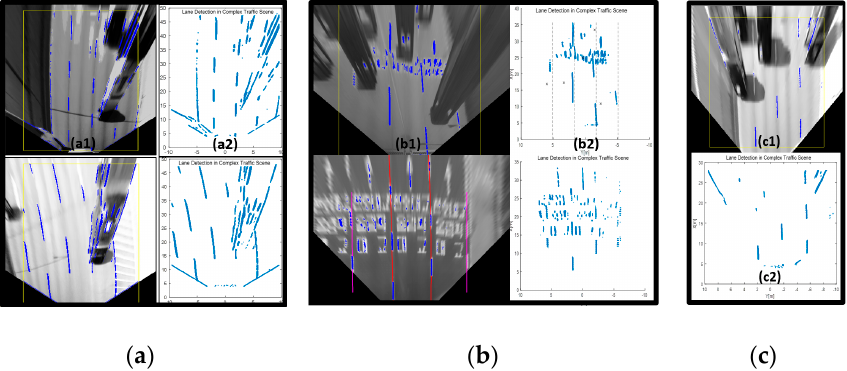
Figure 6. Three bad influential factors for lane detection: ( a ) a challenging scenario for road adjacent lane detection due to a vehicle in the side lane, ( b ) a challenging scenario for road lane detection due to road markers, ( c ) a shadowy road condition, with (a1,b1,c1) lane candidate points from a bird’s-eye view and (a2, b2, c2) lane candidate points in the vehicle coordinates.